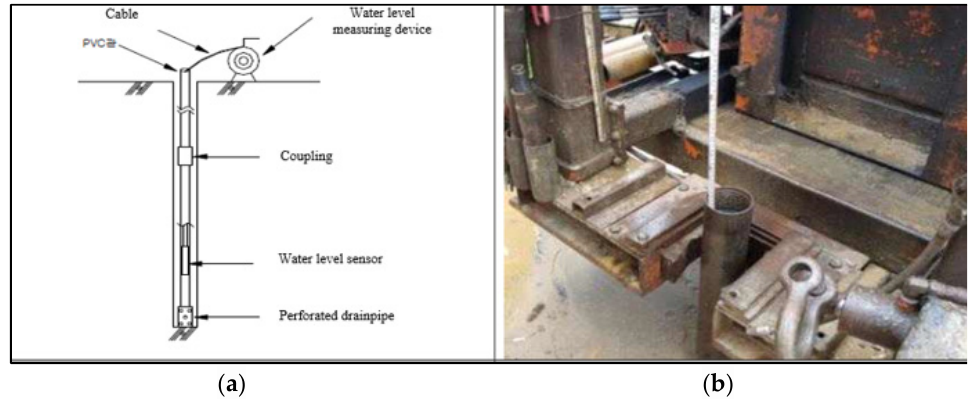
Figure 25. Measurement of groundwater level, ( a ) typical detail, ( b ) in the study area.